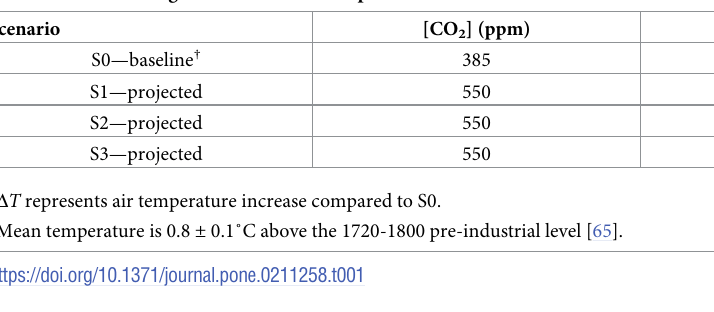
Table 1. Climate change scenarios for model